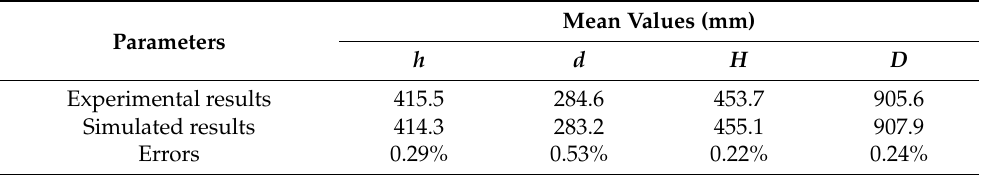
Figure 10. ( a ) Experimental, ( b ) simulated drums, ( c ) microstructures, and ( d ) the α phase volume fractions of experimental and simulated results. Table 2. The critical parameters of materials and hot forging